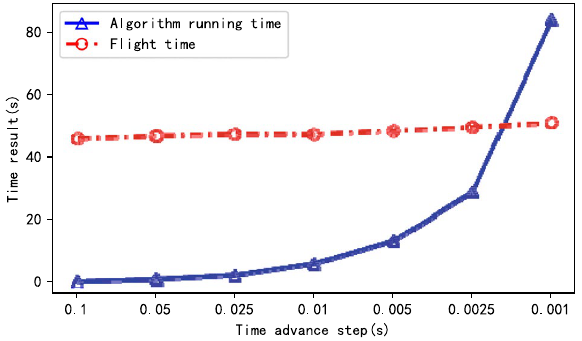
Figure 9. The execution time of the PPF-based algorithm and the flight time of the UAV formation in the simulation under different ∆t.